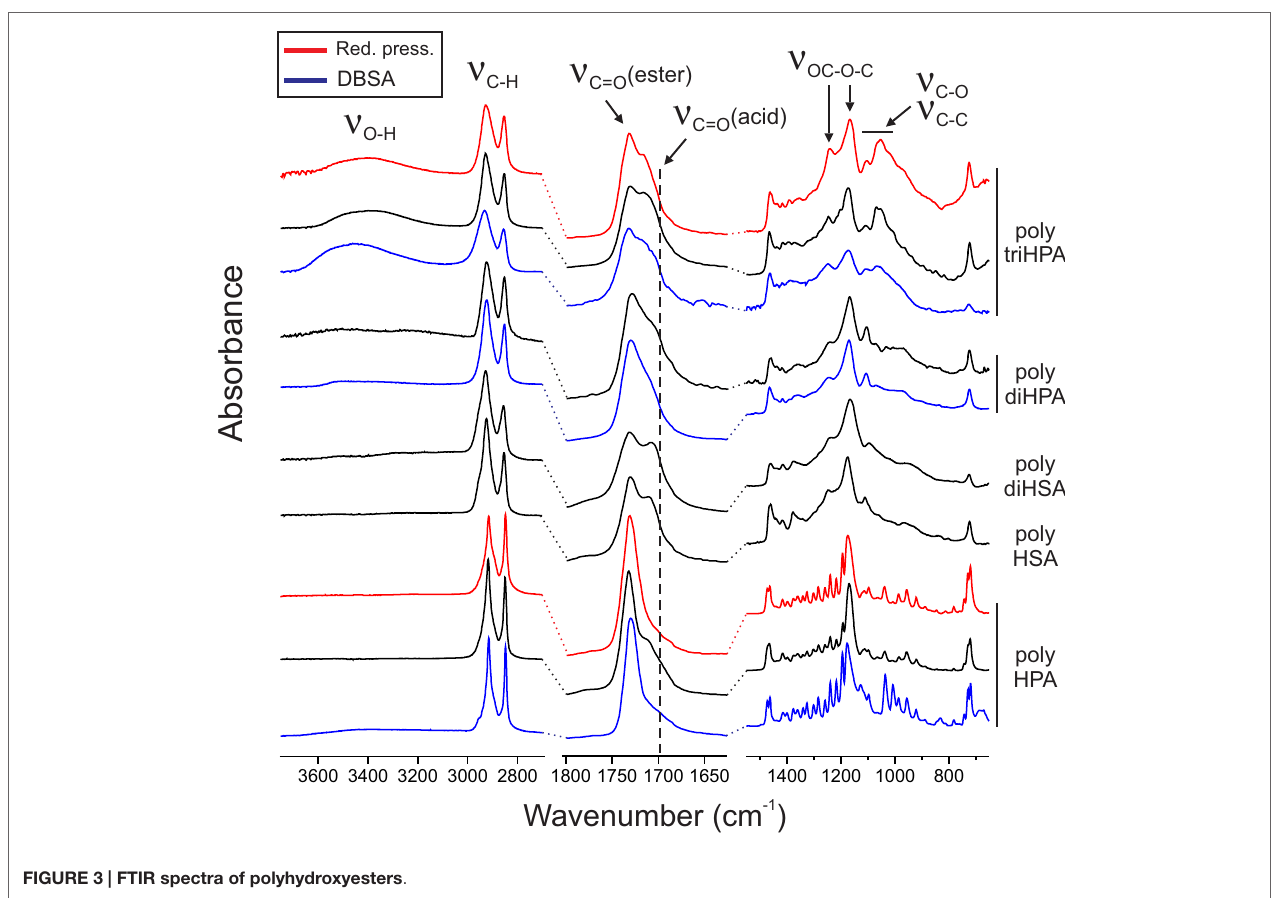
FigUre 3 | FTir spectra of polyhydroxyesters